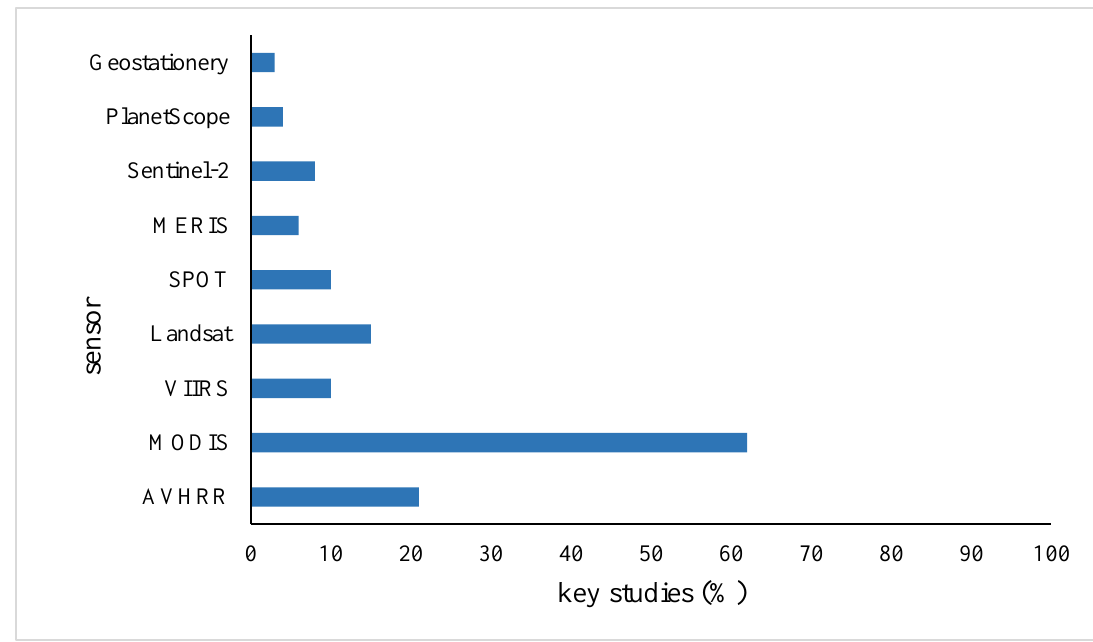
Figure 1. Percentage of polar orbiting and geostationary sensors used for estimating and monitoring LSP in rangelands.